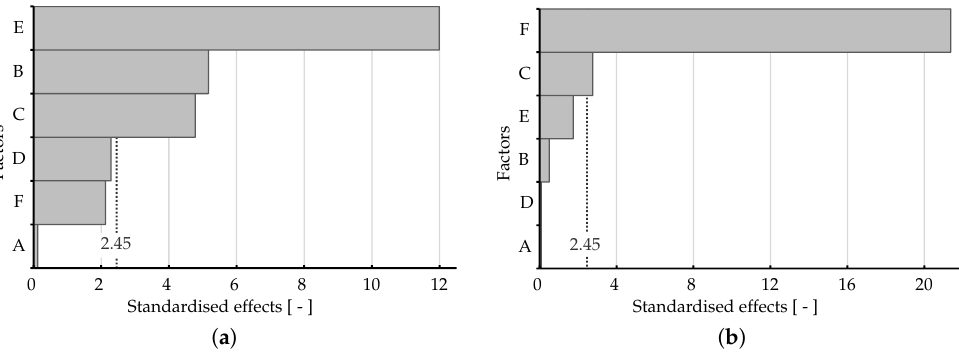
Figure 10. Pareto diagrams of standardized effects, significance level α = 0,05, A: h BP , B: λ Bristle , C: λ Rotor , D: λ Seal , E: α b , F: A , ( a ): Response variable: Heat flux distribution, ( b ): Response